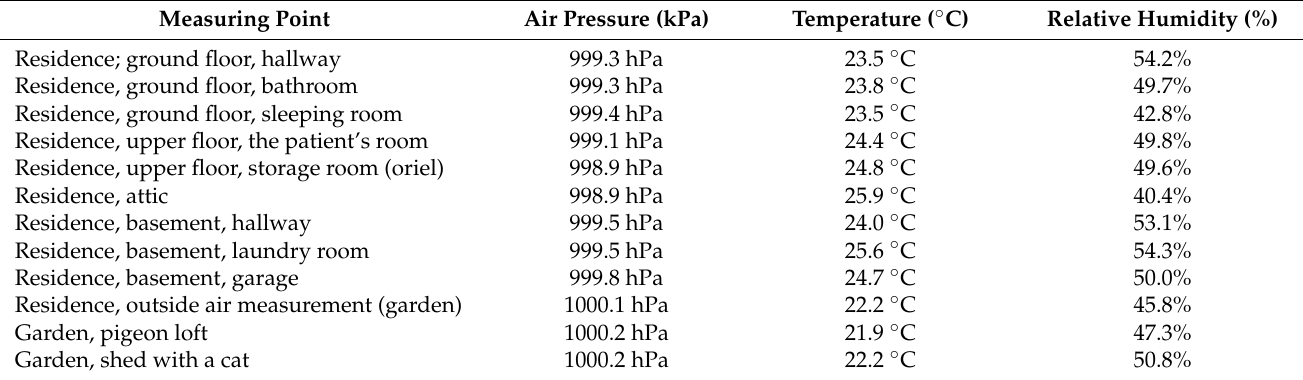
Table A1. Measurement of the weather conditions during the